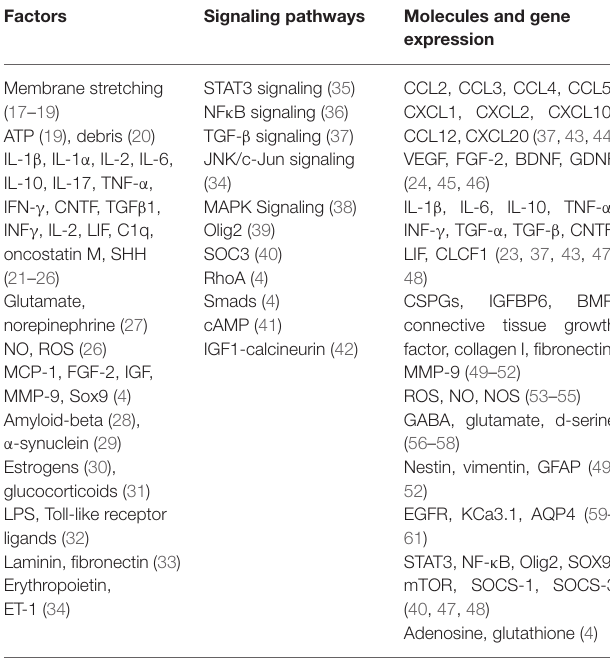
TABLE 2 | The activation of astrocytes.